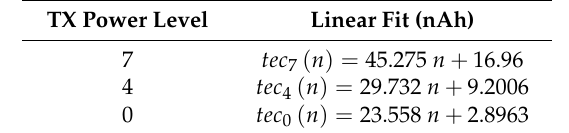
Table 6. Empirical model for transmission: required electric charge to transmit n bytes.